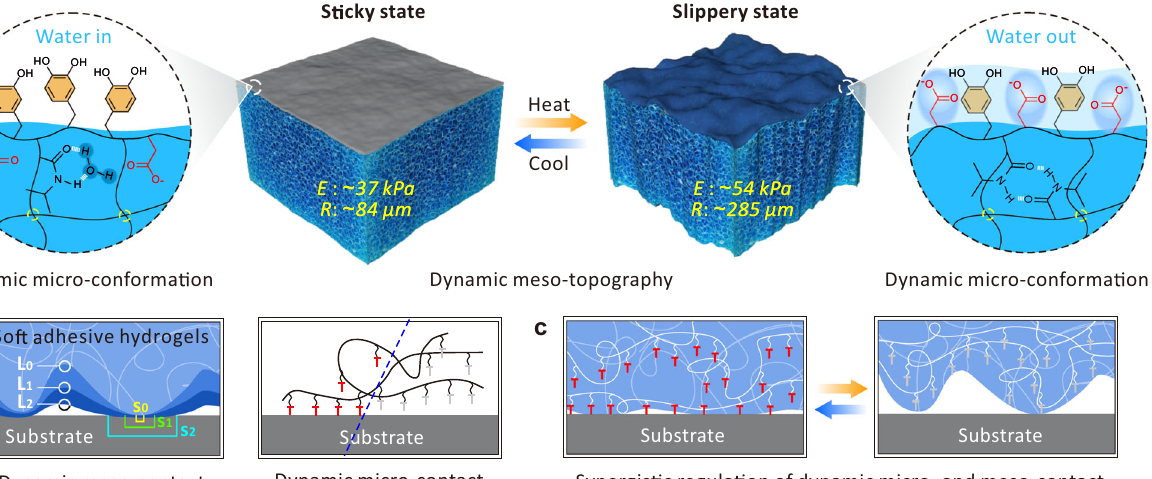
synergistic regulation of dynamic micro- and meso-scale contact. The effect of adhesive components (PDMA) ( d ), material modulus ( e ), and smart components (PNIPAAm) ( f ) on adhesion strength. g The sticky and slippery state of the DMCS- hydrogels against iron sheet at high and low temperatures. Photographs ( h ) and nominal stress versus stretch curve ( i ) of the DMCS-hydrogel, stretched to more than 7 times its original length. The hydrogel was colored with Rhodamine B for visualization. Error bars represent the standard deviation from at least three replicates. Data in d , e , and f are presented as mean values±SD. λ